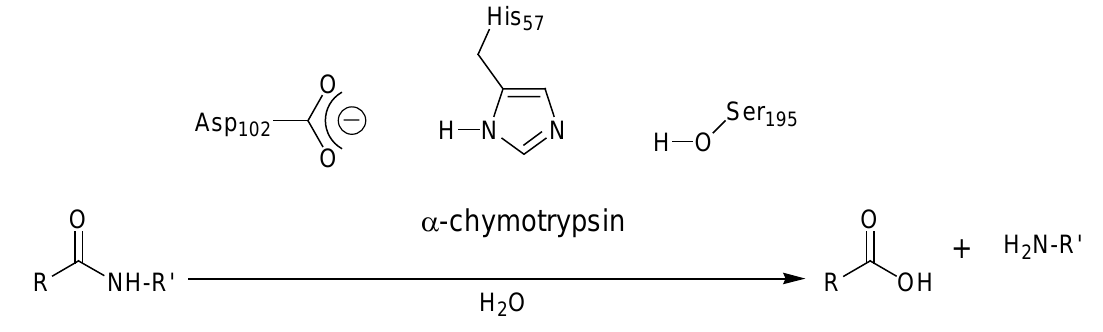
Figure 1 : The catalytic triad of α -chymotrypsin for peptide